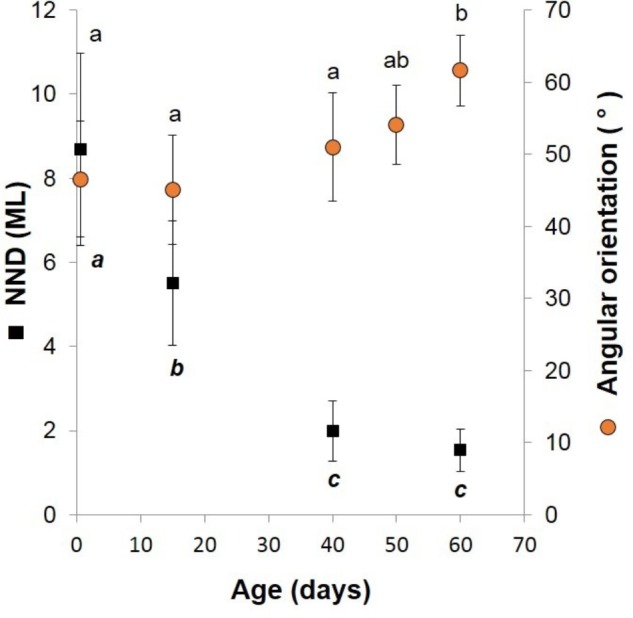
Doryteuthis opalescens. Relationships between the nearest-neighbor distance (NND) and swimming angles of orientation and age in squid reared for 60 days after hatching. The NND was measured as the distance between the eyes of randomly selected paralarvae and was standardized to the mean ML of measured squid. Symbols and bars indicate mean and SD, respectively; means with same superscript letters denote no statistical difference (t-test, p > 0.05).